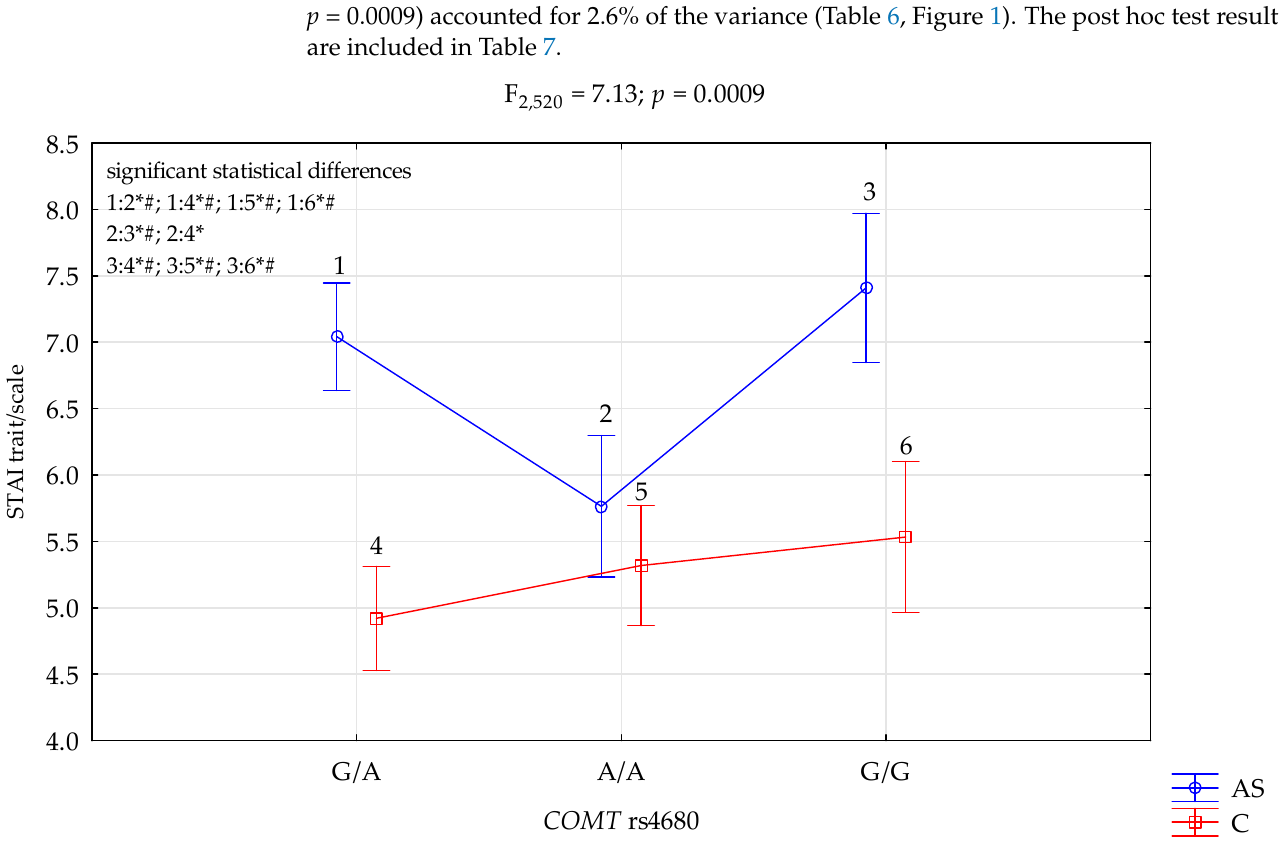
Figure 1. Interaction between patients addicted to stimulants (AS)/Control (C), COMT rs4680 and STAI trait/scale. *—significant result, # Bonferroni correction was used, and the p -value was reduced to 0.0083 ( p = 0.05/6 (number of statistical tests conducted)). Table 7. Post hoc LSD (least significant difference) analysis of interactions between patients ad- dicted to stimulants (AS)/-Control (C) and COMT rs4680, the STAI trait scale, STAI state scale, NEO FFI neuroticism scale and NEO FFI extraversion scale.